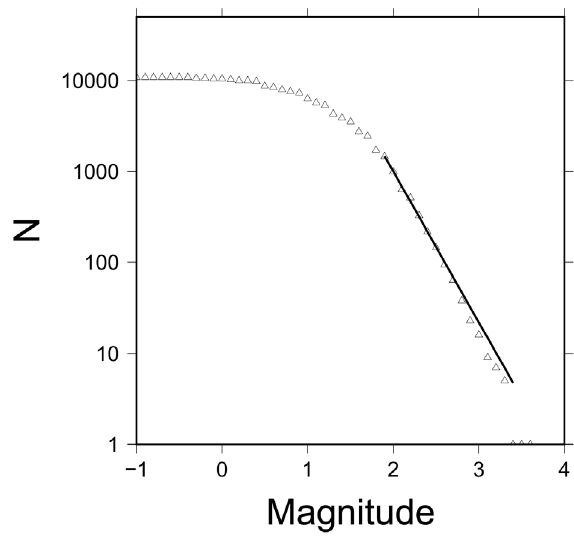
Figure 2. Gutenberg-Richter relationship for the OVO catalogue. The x-axis is the magnitude while the y-axis represents the cumula- tive number of events. Triangles are the experimental data while the solid line is the theoretical relationship with a = 6.32 and b = = 1.66. The line starts at M c